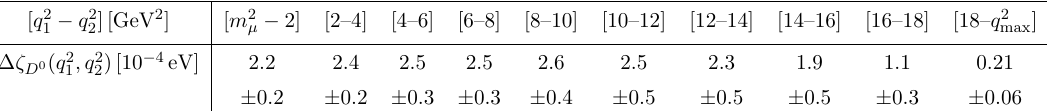
( q 2 ; q 2 ) placed in bins spaced by 2 GeV apart. D 0 1 2